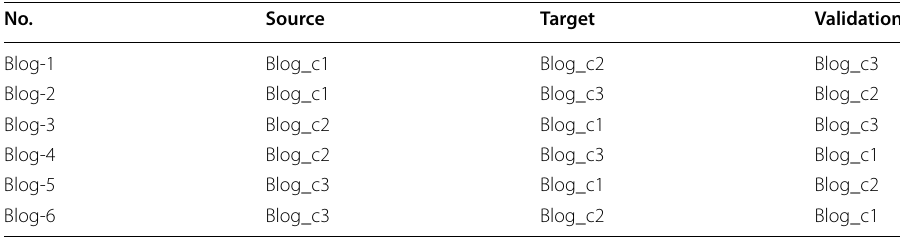
Table 4 Blogcatalog datasets